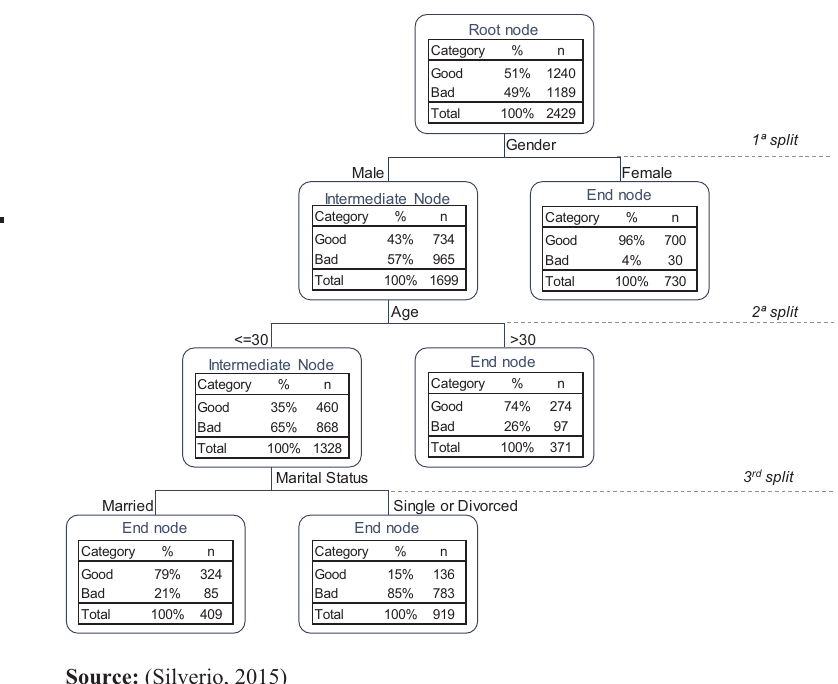
Figure 1. Representation of classi fi cation